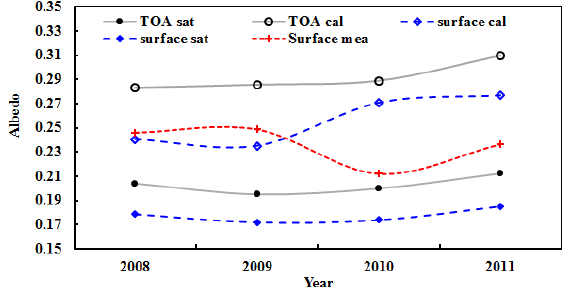
Figure 12. Annual mean albedos during 2008–2011 calculated (cal) and satellite-retrieved (sat) under clear-sky conditions and measured at the surface (mea) at the Qomolangma site. Similarly, using Equations (3)–(5) and hourly measurements with upward global so- lar radiation, annual average albedos at the TOA and the surface were calculated for all- sky conditions during 2007–2020 (Figure 13). Generally, the model-estimated and satellite- derived albedos at the TOA and the surface showed small interannual variations. The empirical model underestimated the TOA albedos by 10.10% and overestimated surface albedos by 16.99% compared to the satellite-derived values during 2007–2020. The error of the retrieved albedo is 85.9% using MODIS data in the short-wave region [52]. During 2007–2020, the model-computed and satellite-derived annual albedos in- creased by 2.85% and 0.27% per year at the TOA, respectively, and decreased by 1.10% and 0.04% per year at the surface, respectively. The measured surface albedos also de- creased by 0.50% per year. The annual mean albedos were 0.301 (0.243–0.356) and 0.209 (0.131–0.313) at the TOA and the surface for the model-computed values, 0.335 (0.318– 0.362) and 0.188 (0.177–0.200) for satellite-retrieved values, and 0.250 (0.230–0.264) for the surface measured values. In general, the empirical model showed reasonable perfor- mance. Both calculated and satellite-derived albedos exhibited similar features, including the finding that albedos at the surface were smaller than those at the TOA. During 2007–2020, the annual averages for atmospheric GLPs (i.e., AF) decreased by 1.41% per year, the water vapor also decreased by 0.37% per year, the calculated G in- creased by 0.22% per year, and air temperature decreased by 0.31 °C. Annual losses of G caused by absorbing and scattering GLPs increased by 0.62% and decreased by 2.14%, respectively, and the total loss decreased by 0.08% per year. It seems that the air temper- ature decline corresponded to a decrease in scattering loss in the atmosphere. It should be noted that to obtain reliable surface albedos, the upward global solar radiation measured in the early morning and late afternoon was not used. To understand basic atmospheric characteristics at Qomolangma, the annual aver- ages during 2007–2020 were reported: AF = 2.63, E = 4.05 hPa, T = 9.48 °C, RH = 31.11%, v = 3.50 ms − 1 , G cal = 2.36 MJ m − 2 , and G obs = 2.34 MJ m − 2 .